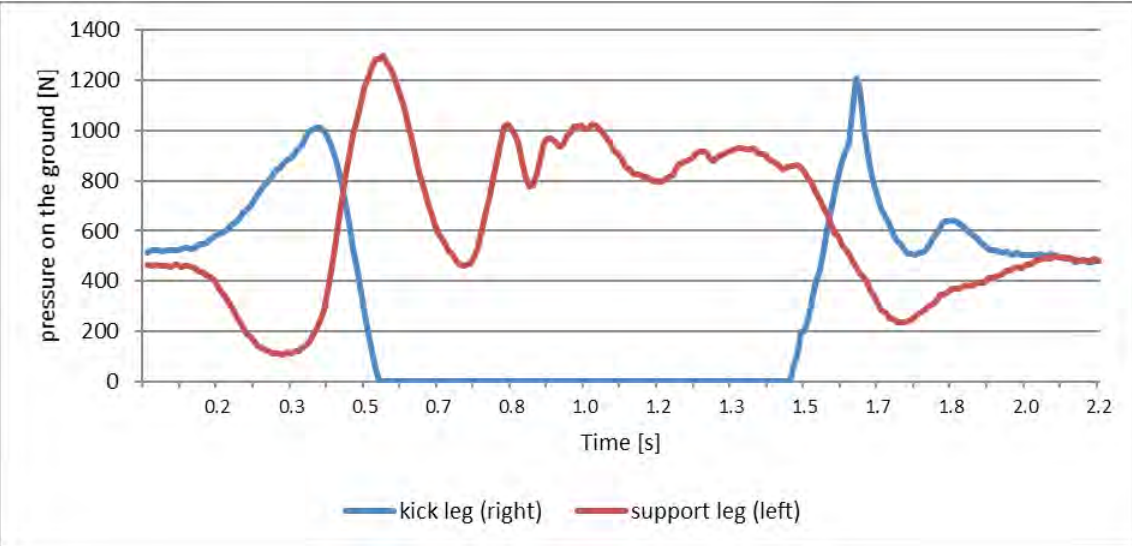
Fig. 1. Changes of foot pressure on the ground while performing the right leg front